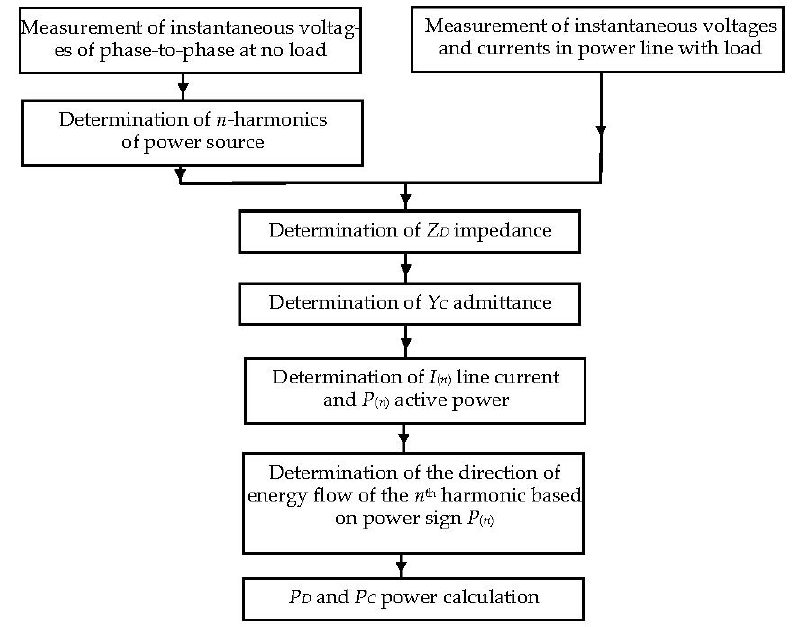
Figure 8. The method of determining the power of a non-linear receiver connected to the power grid.